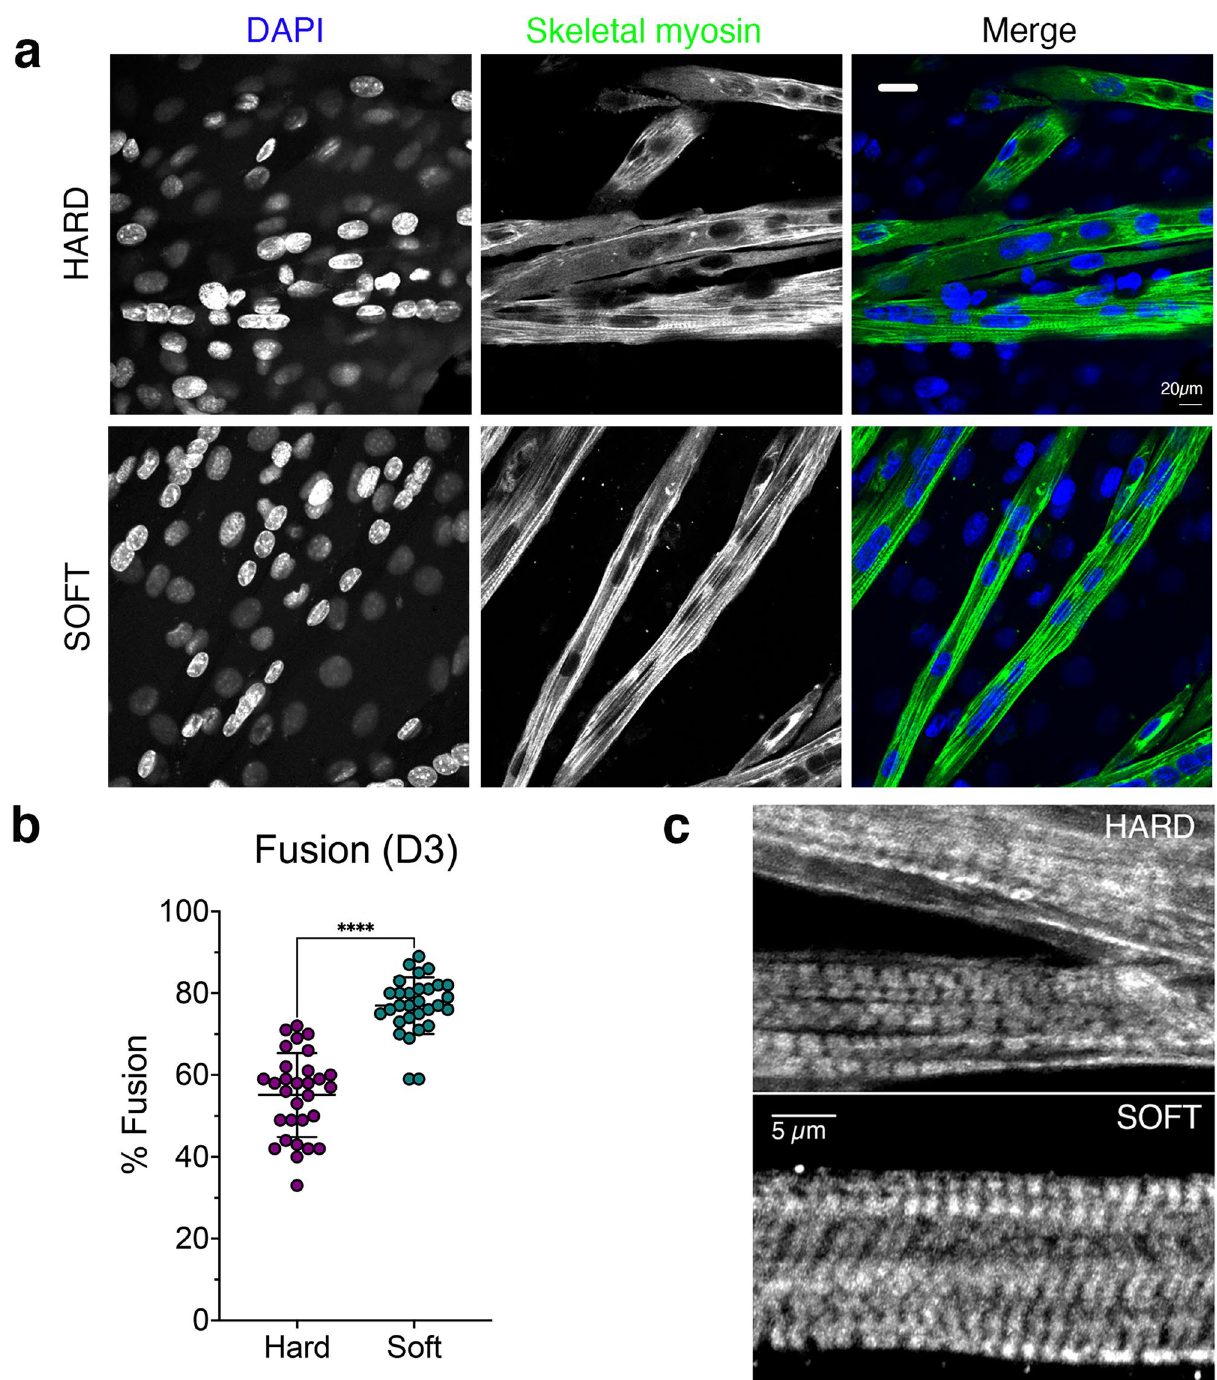
Figure 5. Fusion and differentiation of C1F cells on hard or soft surfaces. ( a ) representative fields of view for differentiating cells stained for nuclei (DAPI) and skeletal myosin, shown in greyscale for each channel, and as blue (DAPI) and green (skeletal myosin) in merged image. ( b ) Fusion index measured for cells on hard (magenta) and soft (green) surfaces at D3. ( c ) Greyscale images of myotubes at day 5 on hard and soft surfaces stained for skeletal myosin, to show sarcomeric